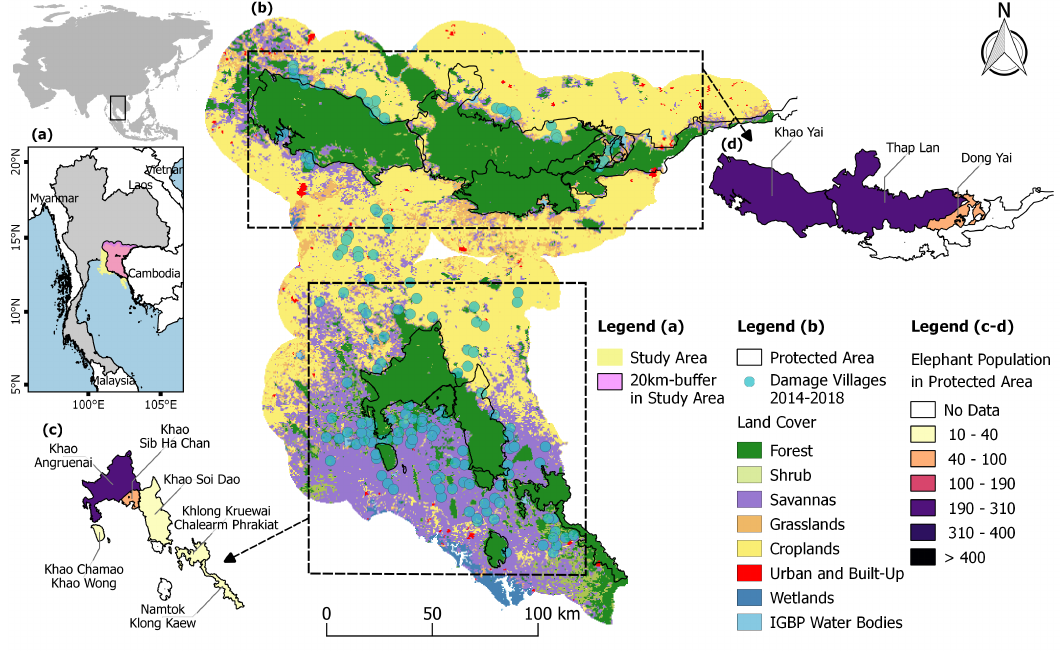
Figure 1. The study area in Eastern Thailand (a). The area is dominated by croplands and savannas, while the damaged villages are located near the forests (b). Human–elephant conflict was modeled within 20-km buffers generated around the nine protected areas (c, d), which are natural habitats for elephant